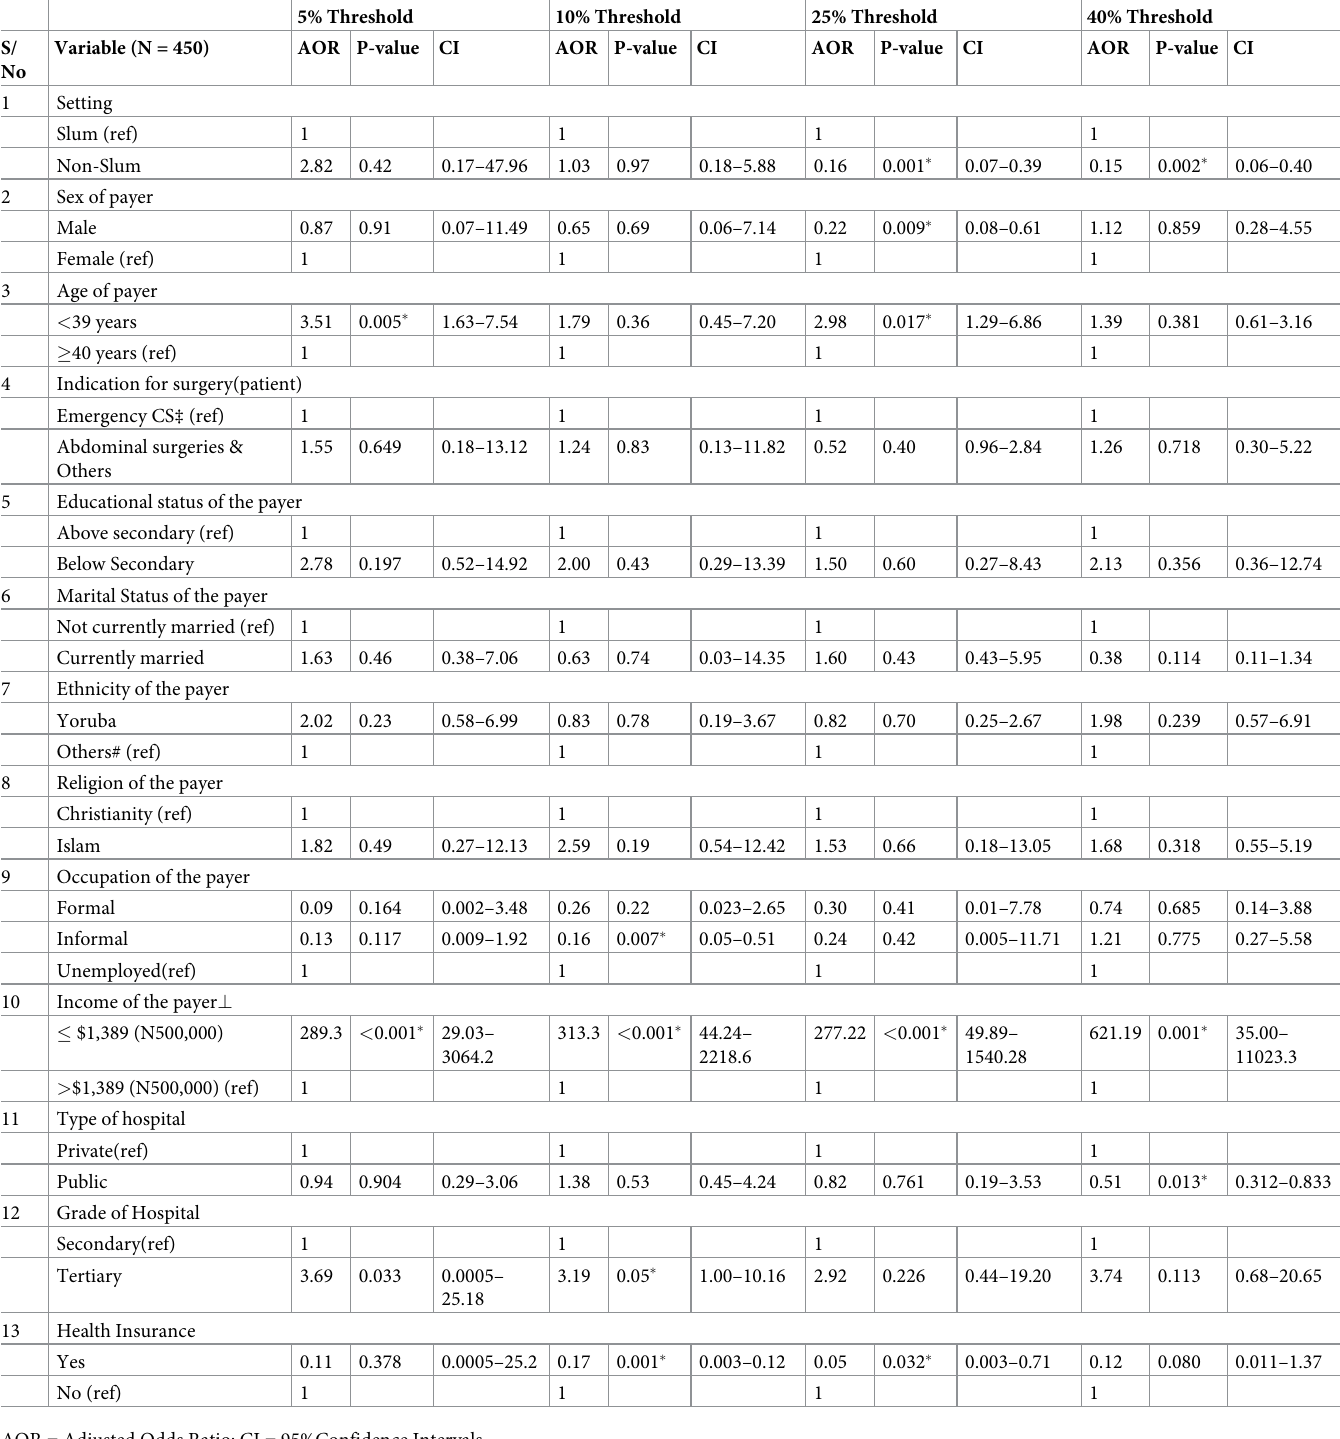
Table 4. Adjusted Odds Ratios (AOR) for respondents at all